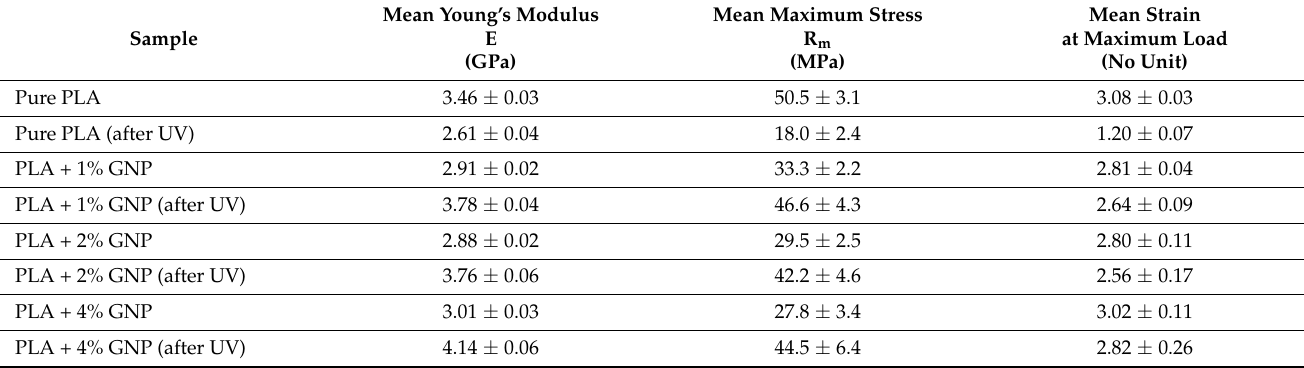
Table 1. Characteristic parameters obtained in tensile tests for all